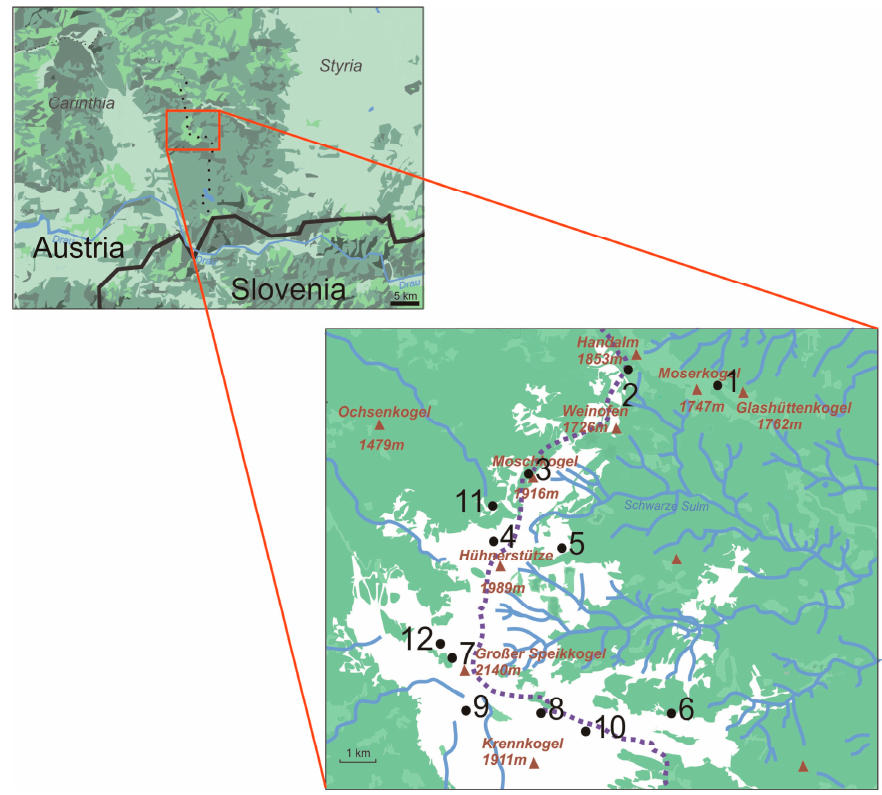
Figure A4. Schematic map of the geographic location of the collecting sites: the enlarged rectangle shows the detailed locations of the sites on the Koralpe mountain range.